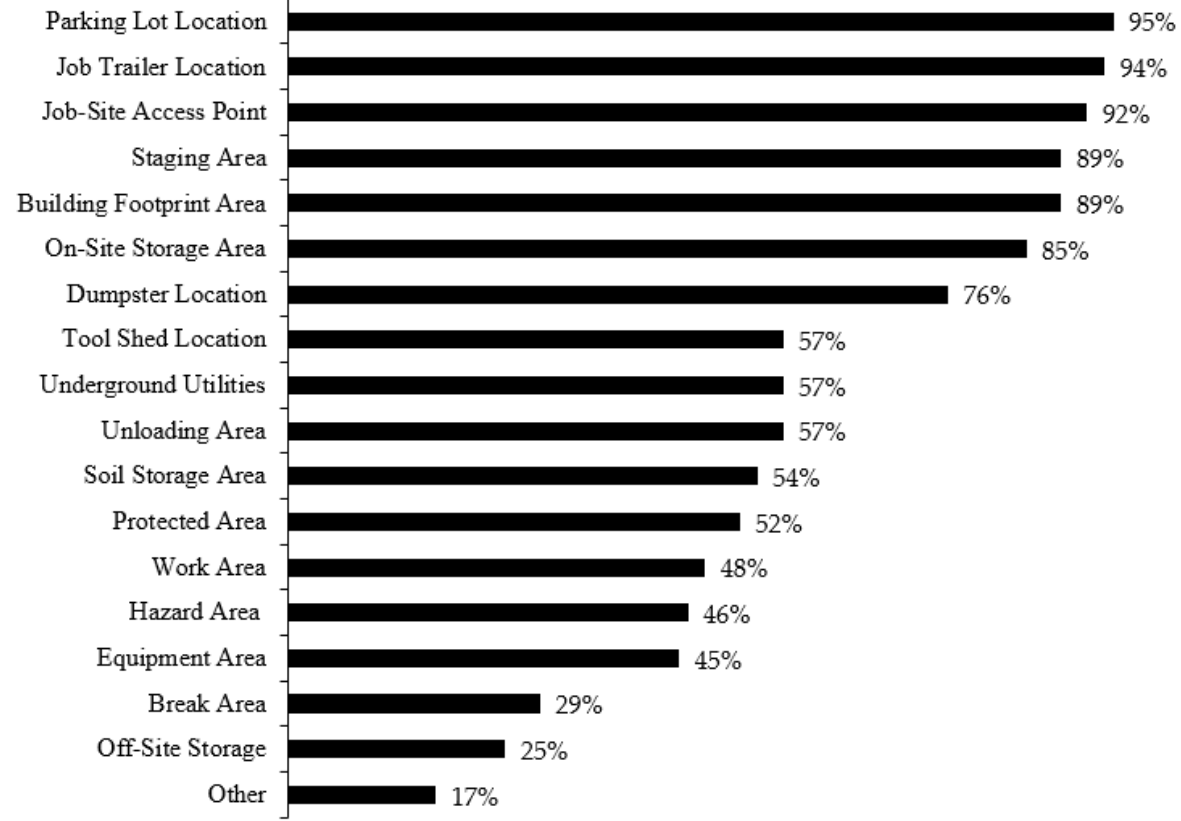
Figure 4. Typical temporary facilities shown on a site utilization plan.